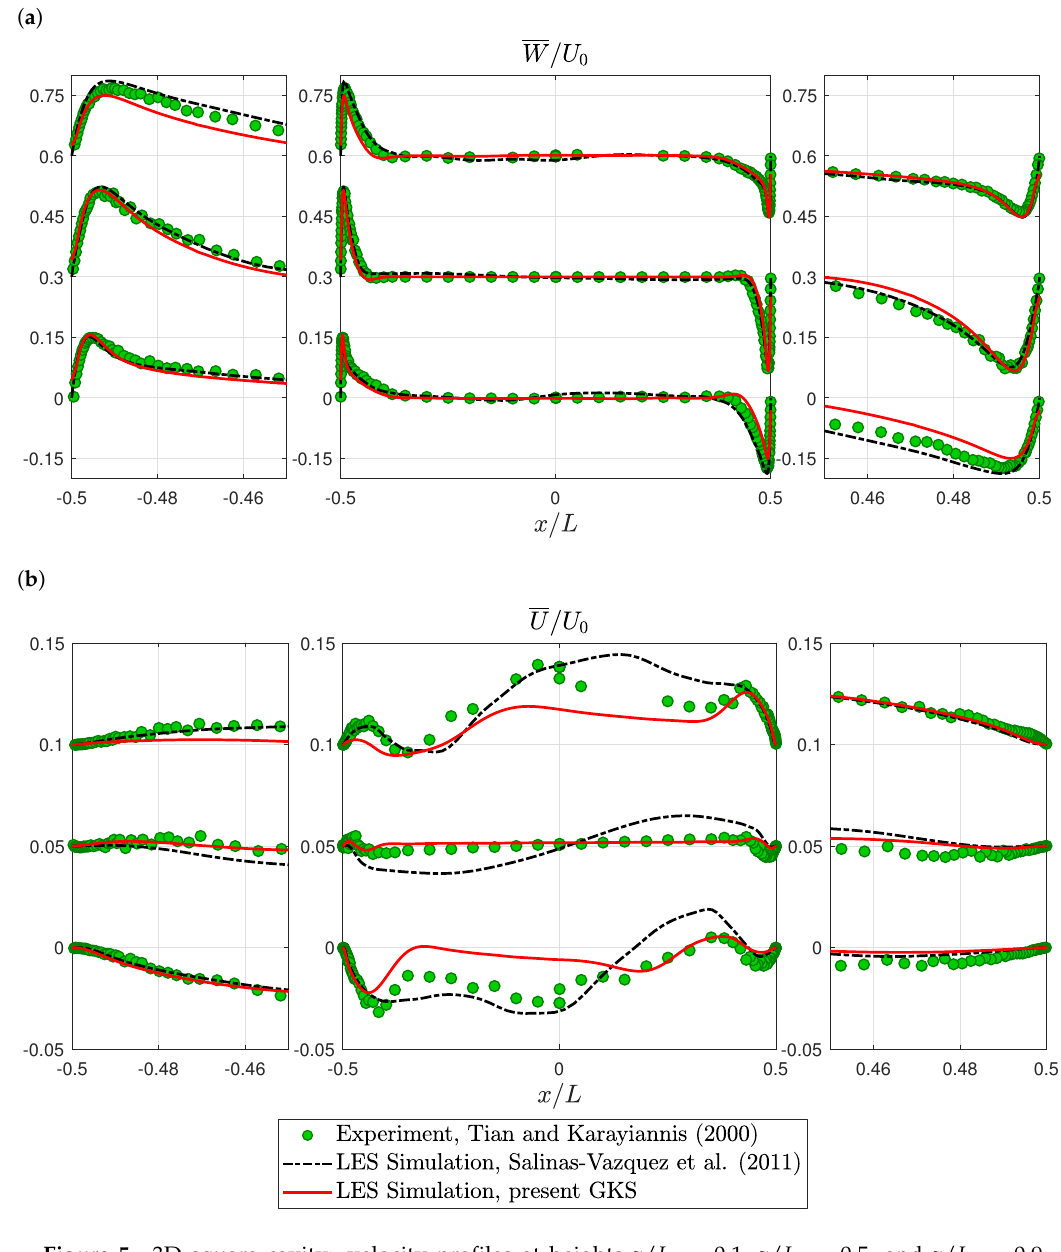
Figure 5. 3D square cavity: velocity profiles at heights z / L = 0.1, z / L = 0.5, and z / L = 0.9 from bottom to top: ( a ) Vertical velocity profiles. For visualization, the profiles are shifted by 0.3. ( b ) Horizontal velocity profiles. For visualization, the profiles are shifted by 0.05. Experimental values from Tian and Karayiannis [70] and simulation values from Salinas-Vázquez et al.